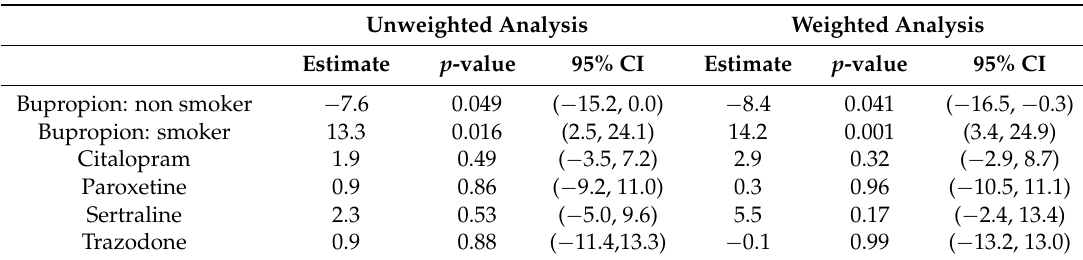
Table 4. Estimated 2-year weight change (lbs) for users of the various drug groups compared to fluoxetine users based on the per-protocol analysis *. Unweighted Analysis Weighted Analysis